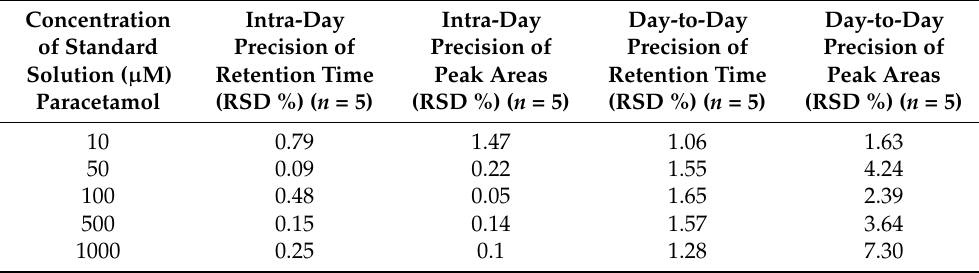
Figure A11. Calibration curve to determine the activity of COX enzyme in rat small intestine. Table A1. Within-day and day-to-day precision of retention time and peak areas of paracetamol standard solutions in drug-free intestinal perfusate.